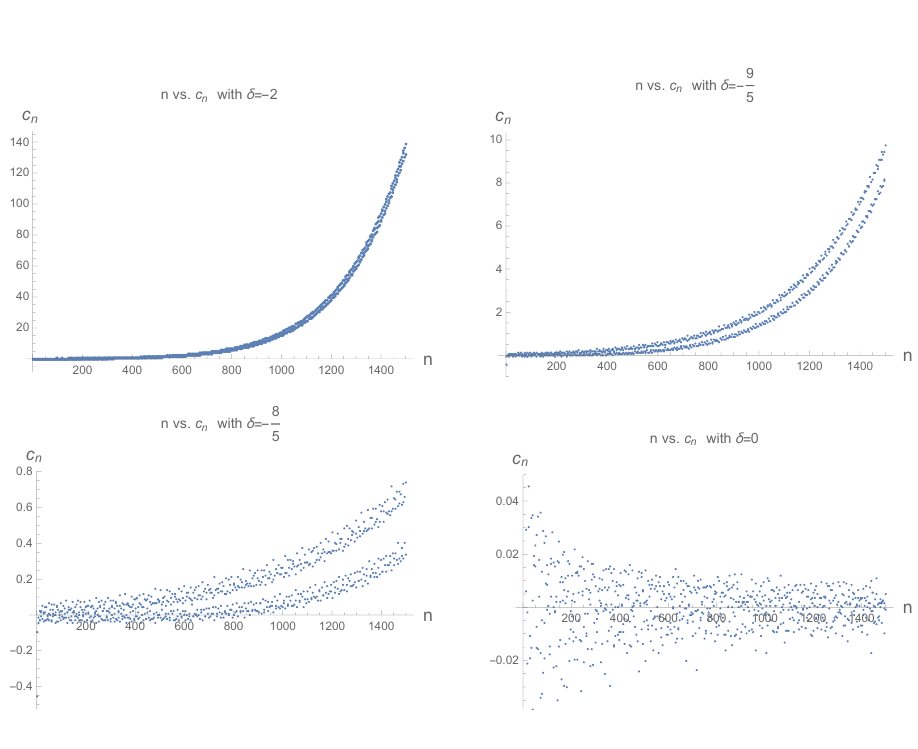
, and 0 with c = 30 . , − 8 5 5